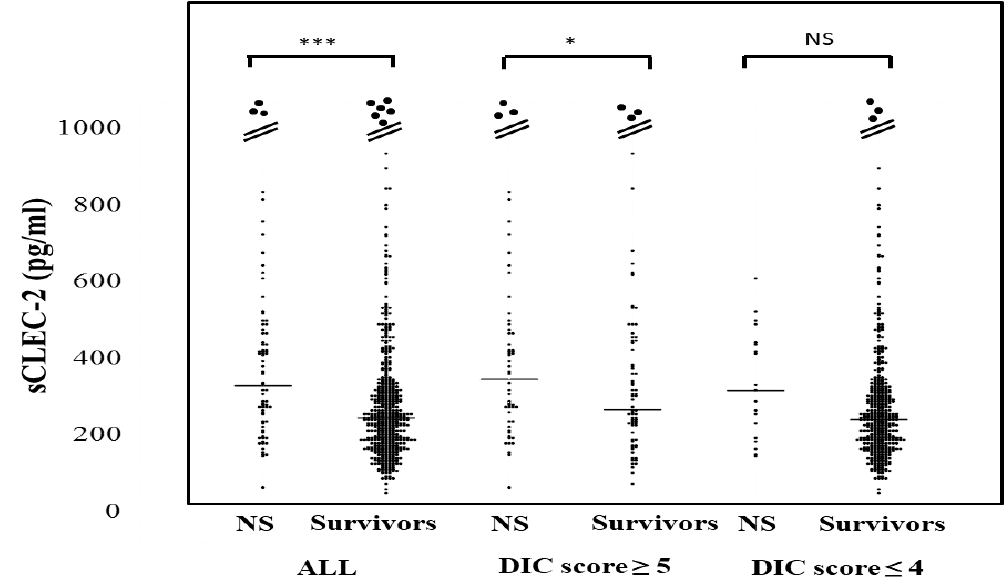
Figure 3. sCLEC-2 levels in survivors and non-survivors. NS; non-survivor; * p < 0.05; *** p < 0.001; NS. not significant.